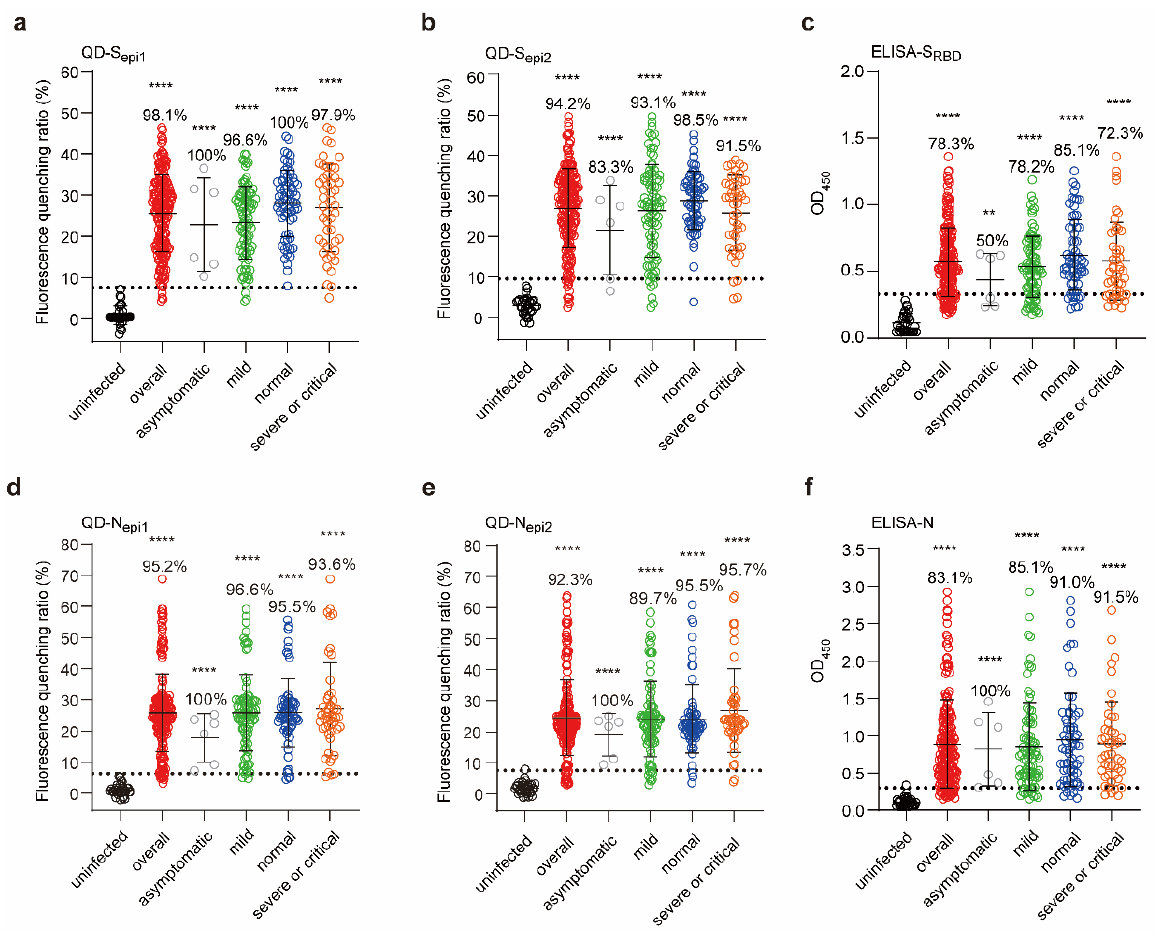
Figure 5. Fluorescent QD-peptides biosensors exhibit excellent clinical sensitivity. ( a , b , d , e ) The reactions of QDs coupled with S epi1 ( a ), S epi2 ( b ), N epi1 ( d ), and N epi2 ( e ) to the 207 COVID-19 convalescents serum samples and 32 uninfected human serum samples. ( c , f ) The reactions of S RBD and N proteins with the 207 COVID-19 convalescents serum samples (overall, red) and 32 healthy human serum samples (black) by ELISAs. All serum samples were diluted at 1:2000. The convalescents were classified as asymptomatic (grey, n = 6), mild (green, n = 87), normal (blue, n = 67), severe or critical (orange, n = 47) according to the illness severity. The horizontal dotted lines in ( a – f ) indicated the cutoff value was the mean value +3 SD of uninfected human serum samples. The percentage is the positive detection rate. Dots represented the average of two or three independent measurements. Lines and error bars indicate the mean and SD of each group, respectively. Asterisks (*) indicate significance when the indicated group compared with the uninfected group and were carried out with the unpaired t -tests for each experiment (** p < 0.01, **** p <